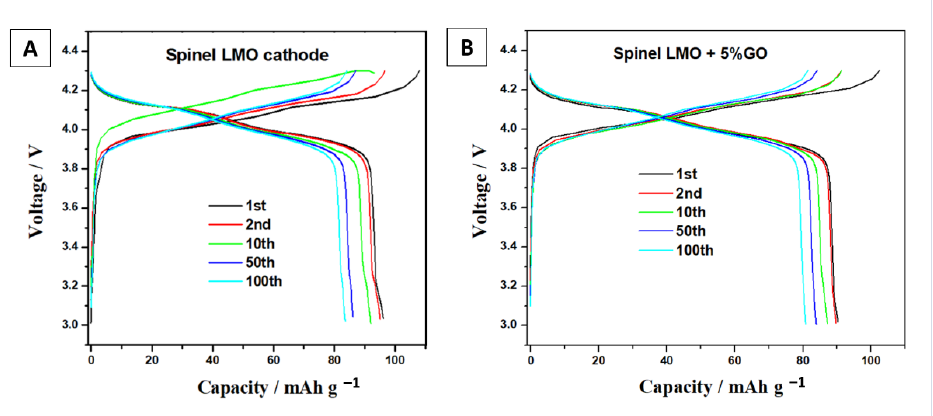
Figure 6. Charge-discharge curves of LMO ( A ) and LMO + 5%GO; ( B ) spinel electrode for Li-ion battery at the voltage range of 4.3–3.0 V with a current of 20 mA g −1 .